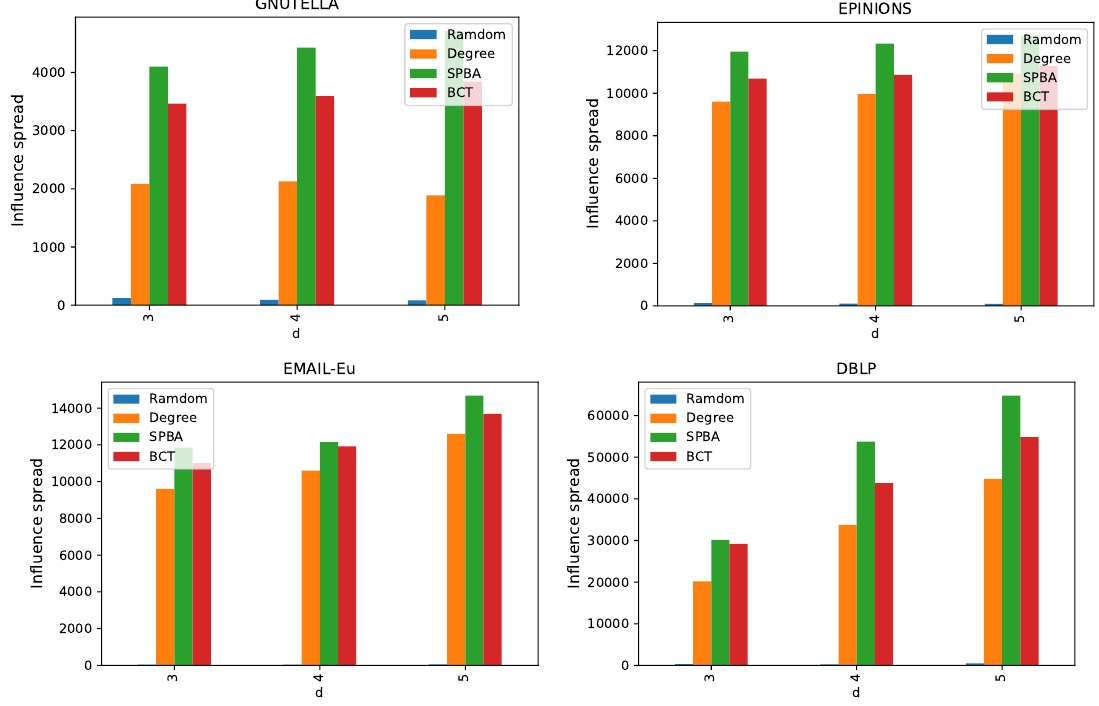
Figure 9. Comparison between different algorithms when τ